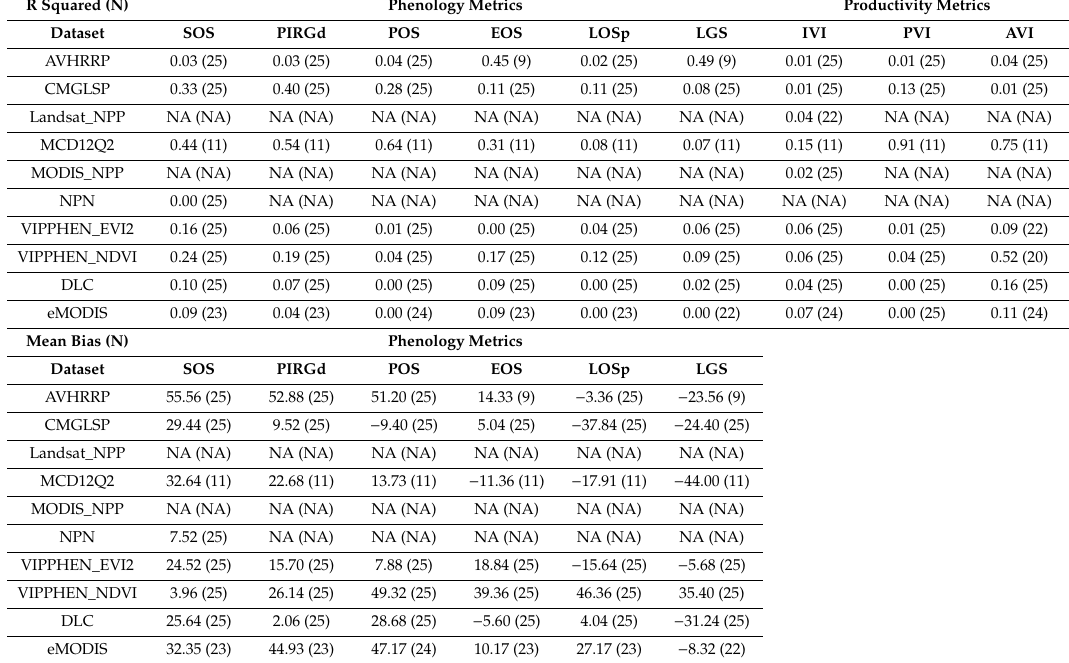
Table A6. Evergreen (EN)